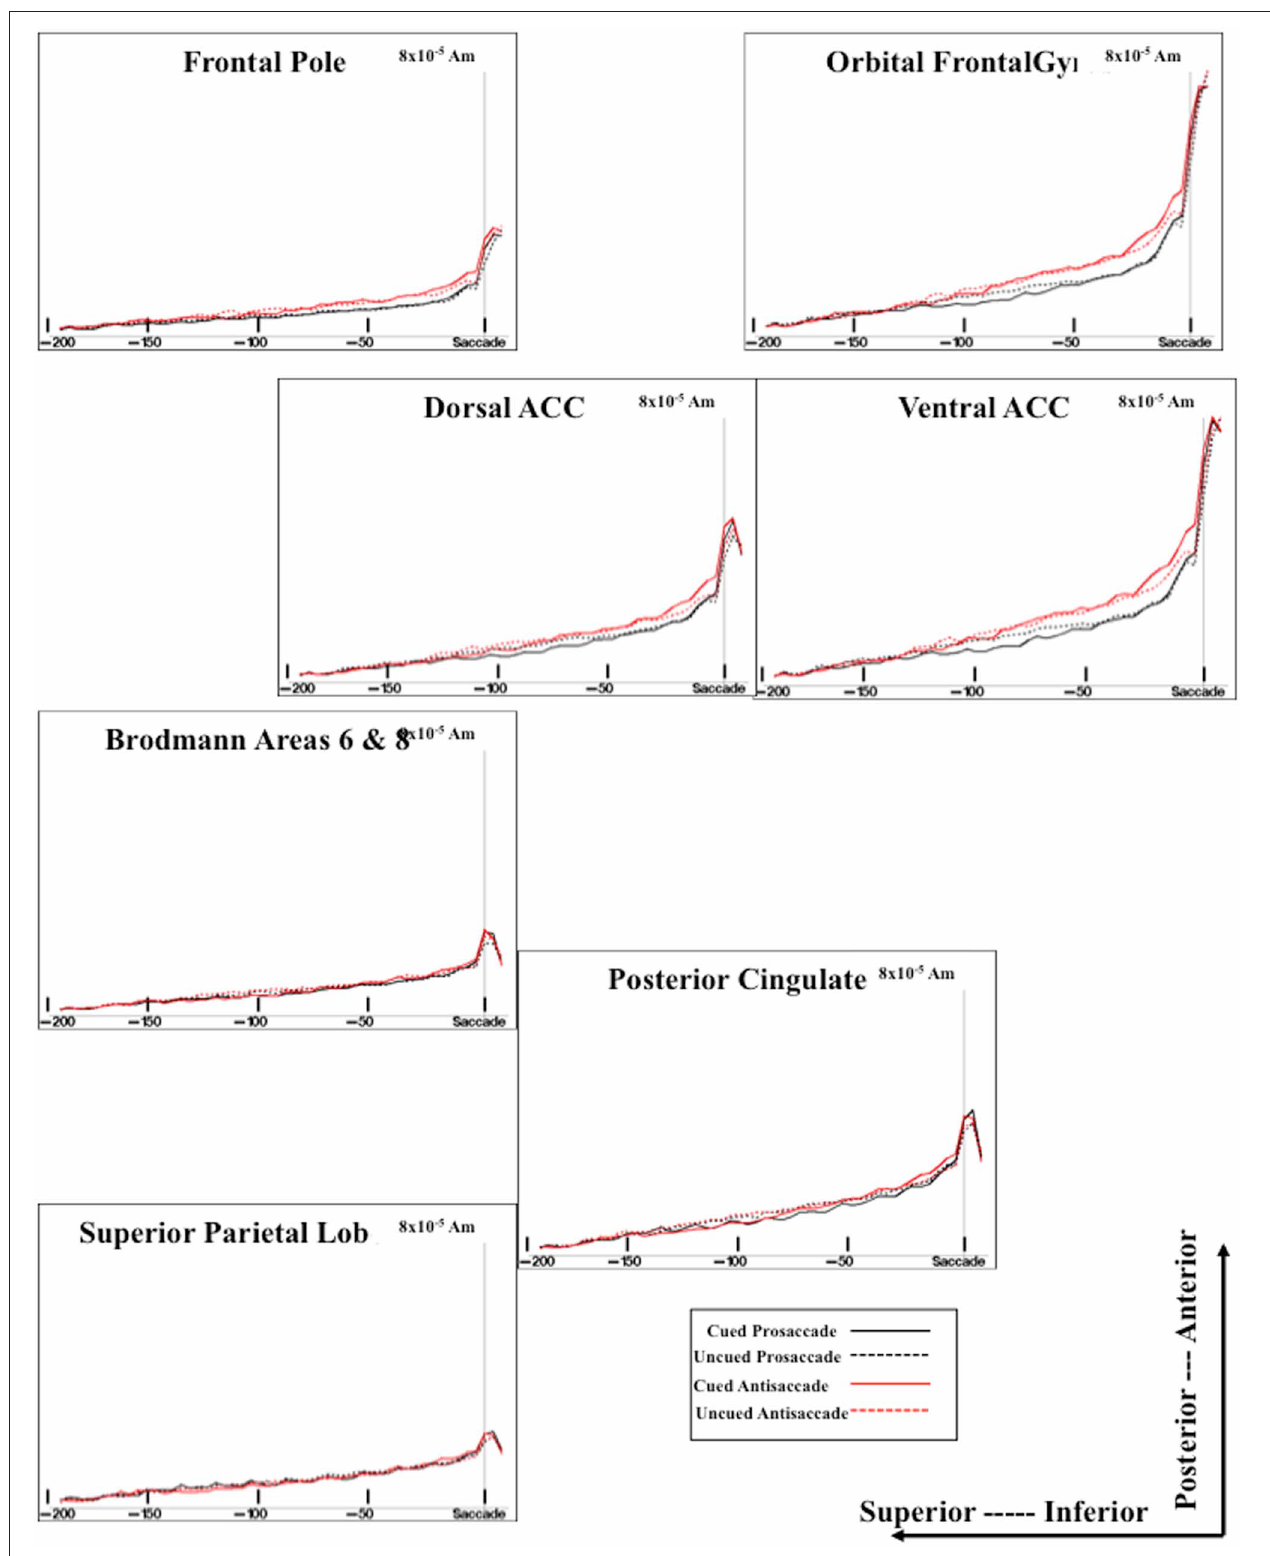
FIGURE 6 | TemporalunfoldingofthecurrentdensitysourcesforthepresaccadicERPactivityfromselectedROIareas. Thisgraphshowsboththedifference between cued and uncued trials on the presaccadic spike potential, and between the antisaccade and prosaccade trials on the presaccadic parietal slow wave.